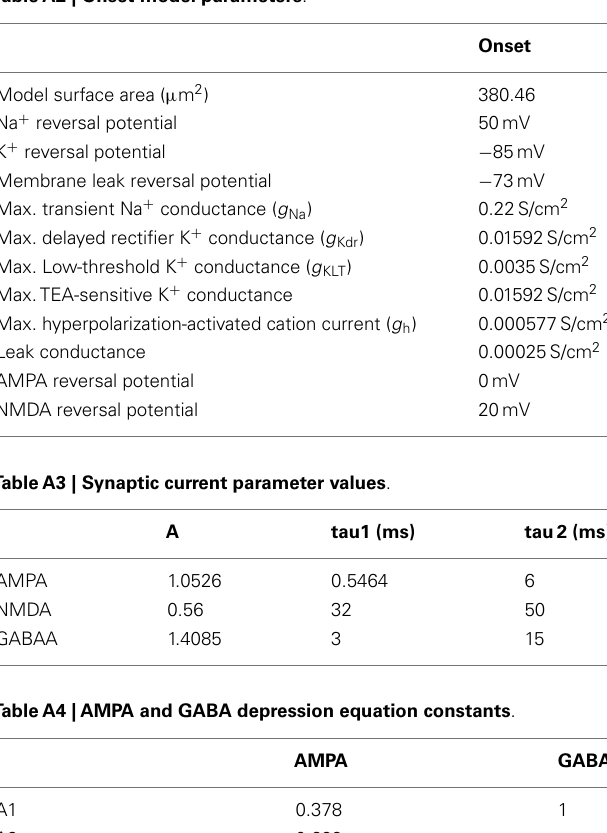
TableA2 | Onset model parameters .